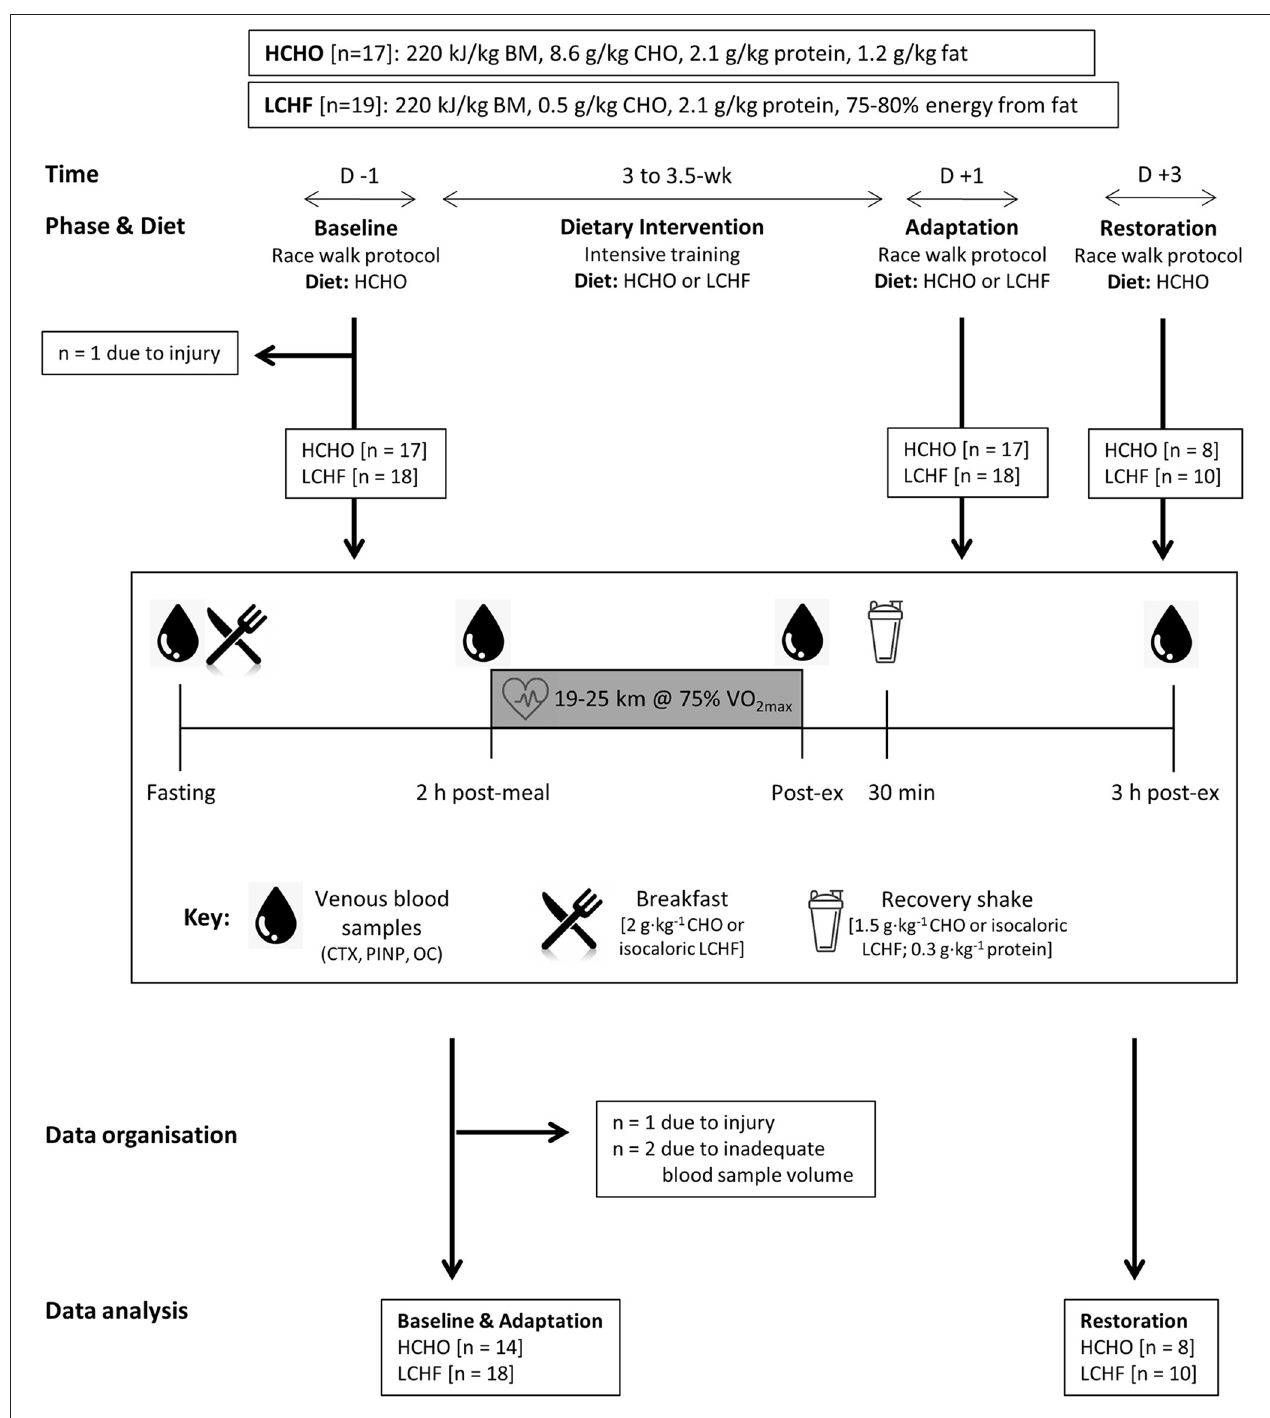
FIGURE 1 | Study flowchart and overview. Thirty-two data sets were gathered from 30 participants who participated in one or more training camps. After Baseline testing on a carbohydrate-rich (HCHO) diet, they elected to follow a 3.5-week energy-matched dietary intervention of either HCHO or ketogenic low carbohydrate-high fat (LCHF) principles. After Adaptation, the participants underwent an acute period of Restoration of high carbohydrate availability. At Baseline and at the end (Adaptation) of this intervention, as well as after acute carbohydrate reintroduction (Restoration) they undertook a test block including a 25km (2h) hybrid laboratory/field race walking protocol at ∼ 75% VO 2 max. Venous blood samples were collected after an overnight fast, 2h after an energy-matched breakfast based on their diet (immediately pre-exercise), immediately post exercise and after 3h of passive recovery during which an intervention-matched recovery shake was consumed at 30min. Blood samples were analyzed for serum concentrations of C-terminal telopeptide of type I collagen (CTX), procollagen 1 N-terminal propeptide (P1NP), and osteocalcin (OC).